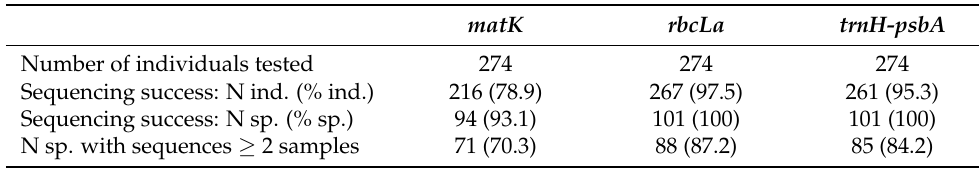
Table 1. Sequencing success of montane forest trees from Ngel Nyaki for rbcLa , matK and trnH-psbA barcode regions. matK rbcLa trnH-psbA Number of individuals tested 274 274 274 Sequencing success: N ind. (% ind.) Sequencing success: N sp. (%